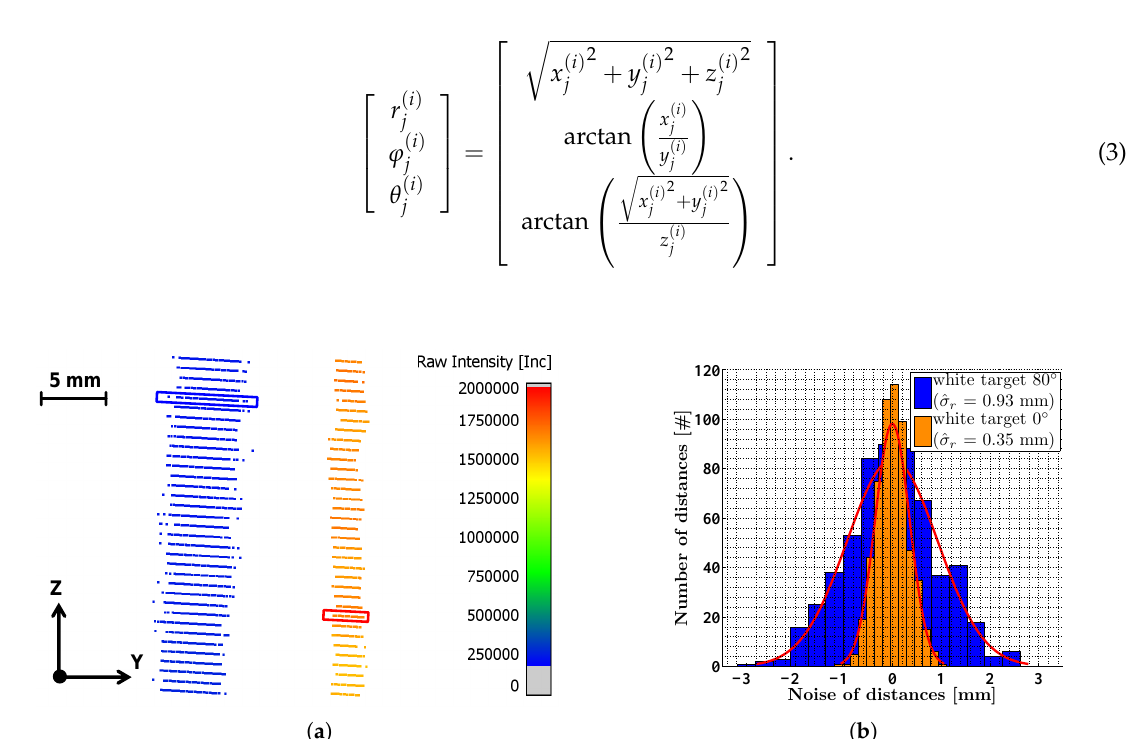
Figure 7. ( a ) two exemplaric scans of the white planar target at a distance of 5 m with an incidence angle of 0 ◦ (orange) and 80 ◦ (blue), color-coded with the related intensities; ( b ) histograms showing the noise of the distance measurement for two arbitrary angular steps marked with boxes in ( a